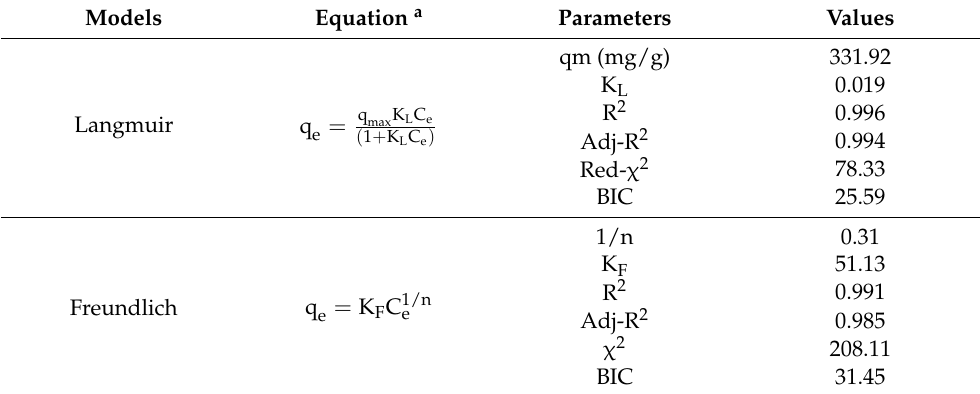
Table 5. Parameters and error function data for sorption isotherm models obtained from non-linear regression forms.